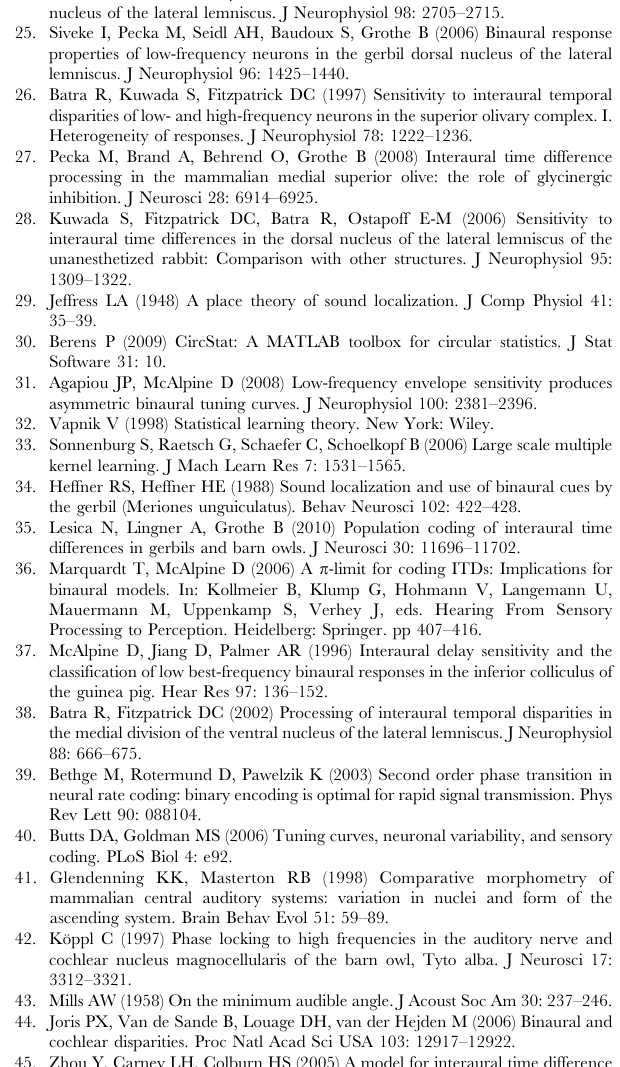
circles represent measured CP, CD | BF values for the cells in the respective best frequency band. (E,F) Single cell mutual informa- tion for uniform (E) and power-law (F) frequency distribution (E is the same grey level plot as C). Figure S2 Robustness of linear rate difference signal. Left column: Linear rate difference code for a model population at which the CP, CD | BF values are jittered around the measured values according to a Gaussian distributions with standard deviation 0 : 023 cyc . for CP and 0 : 22 cyc . for CD | BF (see Supporting Information Figure S3). Right column: Linear rate difference code for the 41 cells in the (best) frequency band between 600 and 800 Hz. The arrangement of the sub panels is identical to those in Figure 5 of the main paper. Figure S3 Robustness of CP, CD estimate. (A) Measured distribution (white) and one example of a surrogate distribution